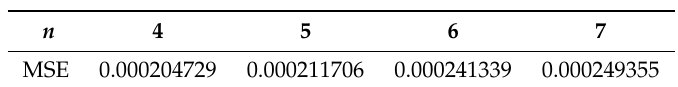
Table 13. n Selection for FB.